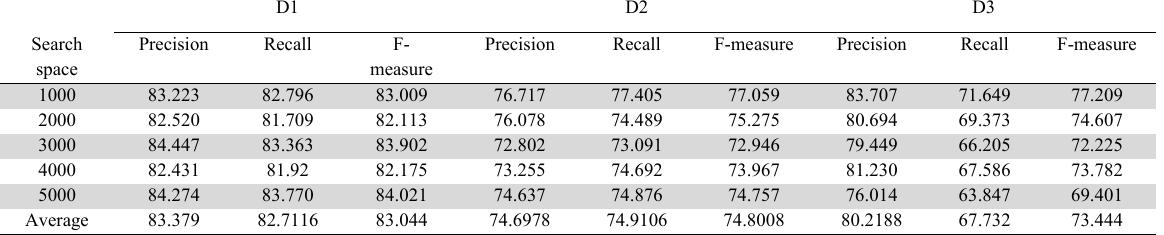
Performance of GARC (macro average %) for each datasets based on the top ranked features using OR D1 D2 D3 Search Precision Recall F- Precision Recall F-measure Precision Recall F-measure space measure